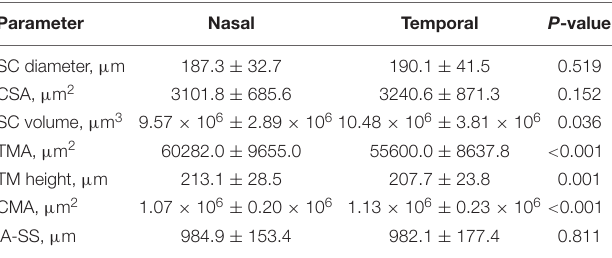
TABLE 2 | Comparison of parameters between nasal and temporal